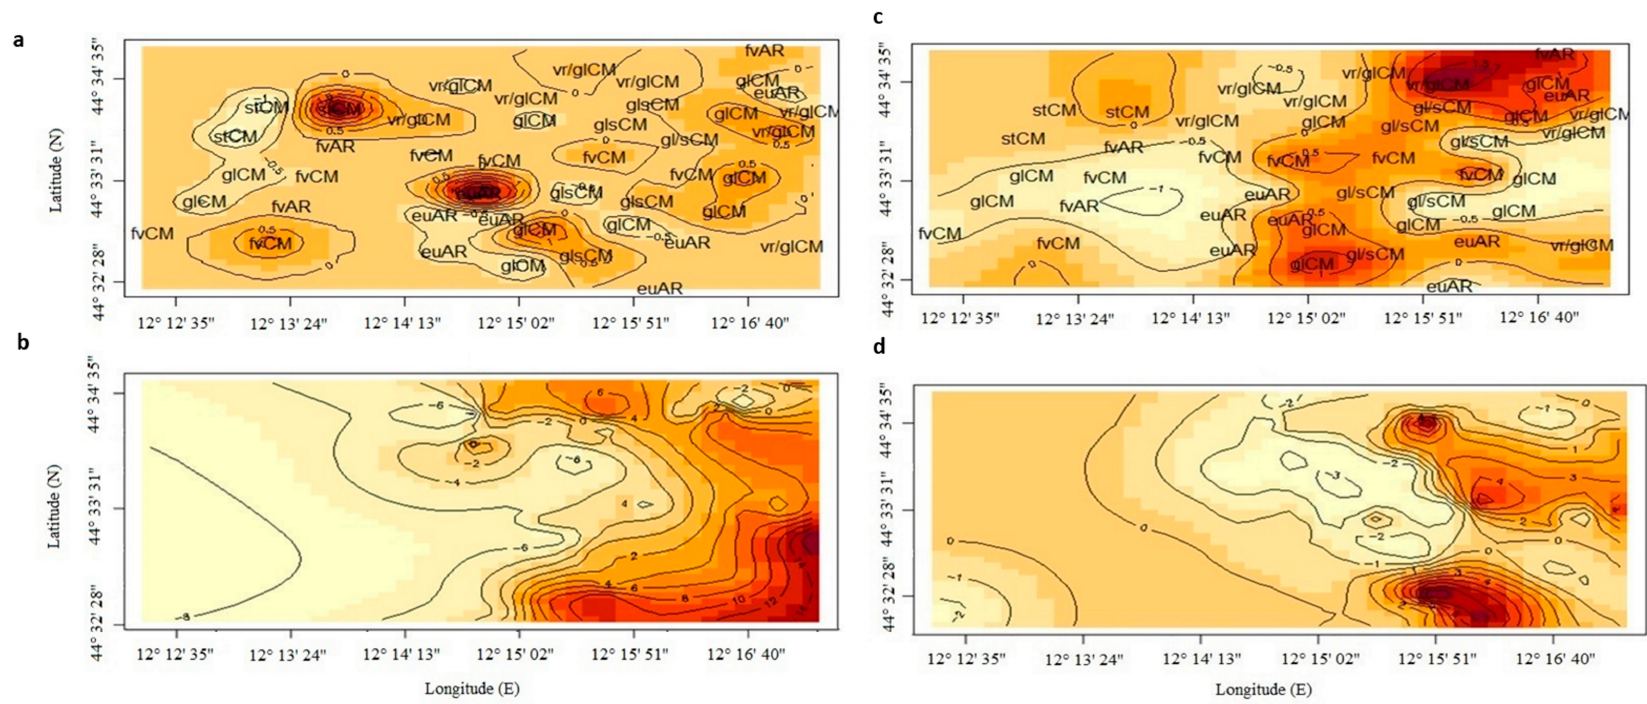
Figure 5. Variogram of residual values of the linear model for the ( a ) 0–30 cm soil depth and ( b ) water body network during the non-irrigation winter period, and for the ( c ) 0–30 cm soil depth and ( d ) water body network during the irrigation summer